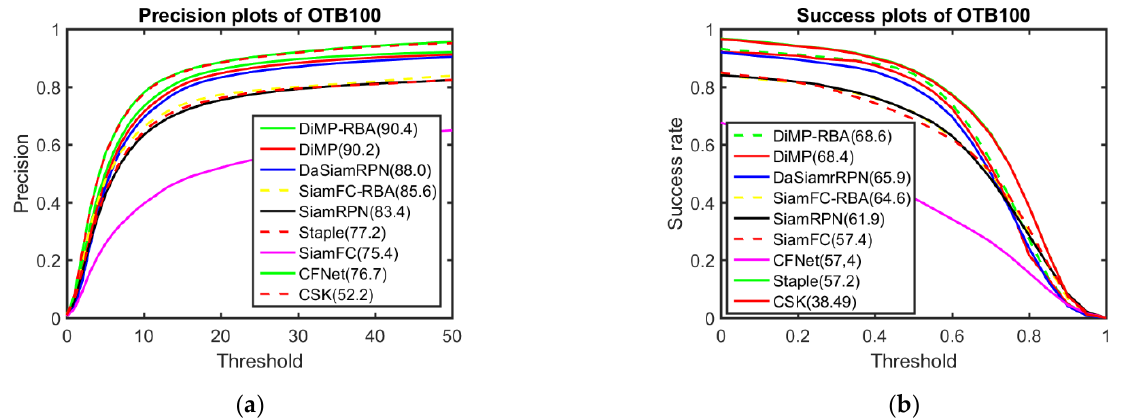
Figure 9. Comparison between the proposed method and baseline trackers on the OTB100 bench- mark: ( a ) precision plots; ( b ) success plots. ( a ) precision plots; ( b ) success